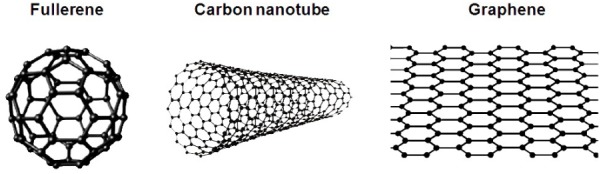
Schematic representation of carbon-based nanomaterials that, due to their unique properties, have shown potential applications in the treatment and diagnosis of stroke: fullerene (hollow sphere of carbon atoms in sp2 hybridization); carbon nanotube (tubular structure of carbon atoms in sp2 hybridization); and graphene (single layer of carbon atoms arranged in a hexagonal lattice in sp2 hybridization). Reprinted (adapted) with permission from Hong et al. (2015).